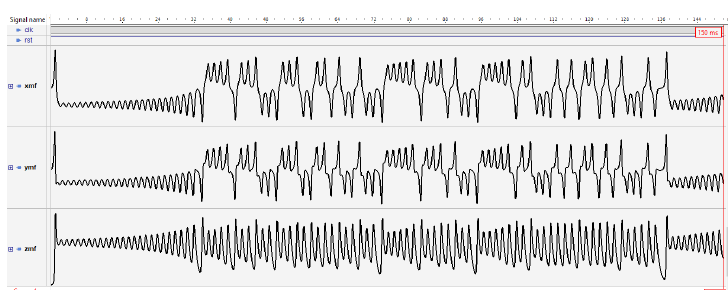
Figure 8. FPGA simulation of CO1 applying BE.